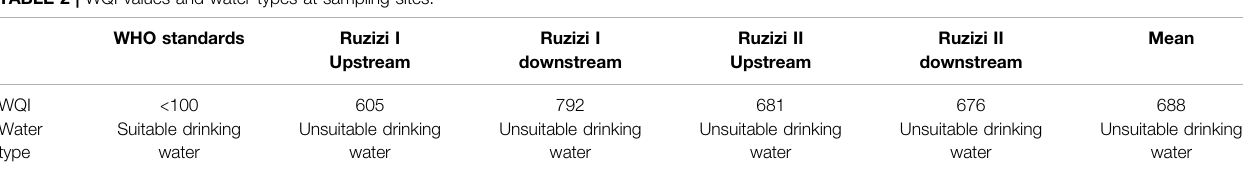
TABLE 2 | WQI values and water types at sampling sites.